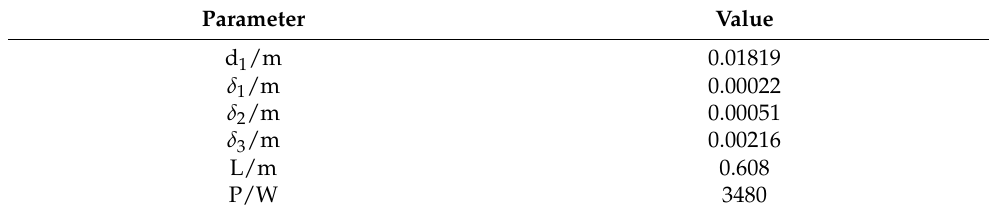
Figure 9. Single-channel model for numerical simulation by Yu [9]. Figure 9. Single ‐ channel model for numerical simulation by Yu [9]. Table 4. The parameters of the numerical simulation model of Yu [9]. Table 4. The parameters of the numerical simulation model of Yu [9].